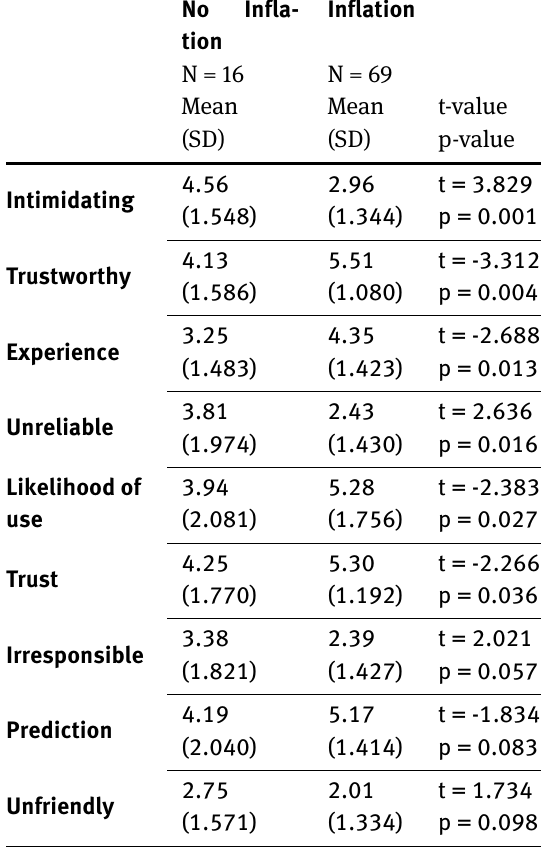
Table 3: Statistical results for inflation Table 4: Statistical results for restarts w.r.t. the frequency of blood pressure measurements and who usually carries out those